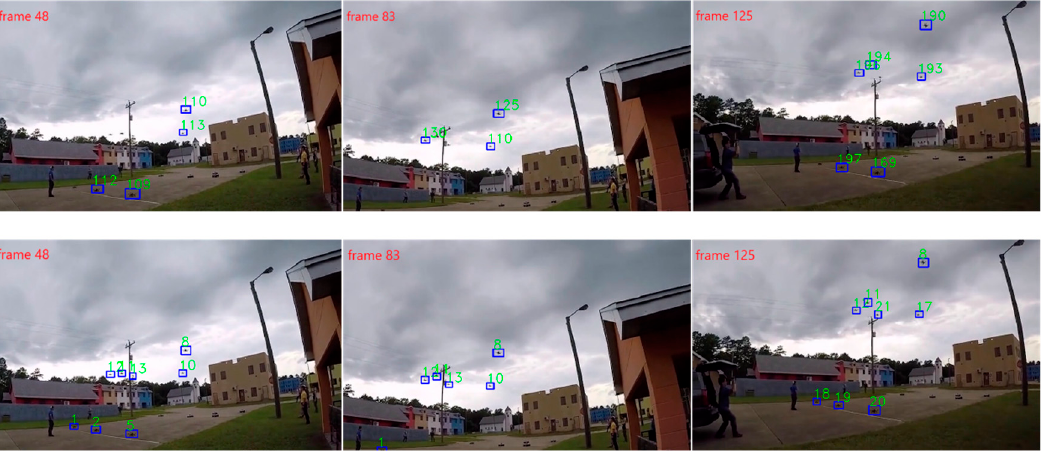
Figure 10. Tracking results of UAVSwarm − 28 (Top: ByteTrack; Bottom: GNMOT; 48th, 83rd, and 125th frames, from left to right).